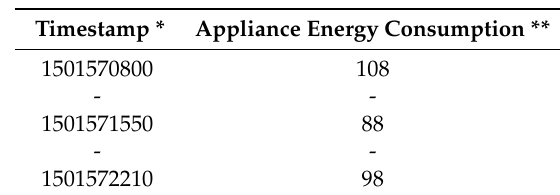
Table 8. Raw data: